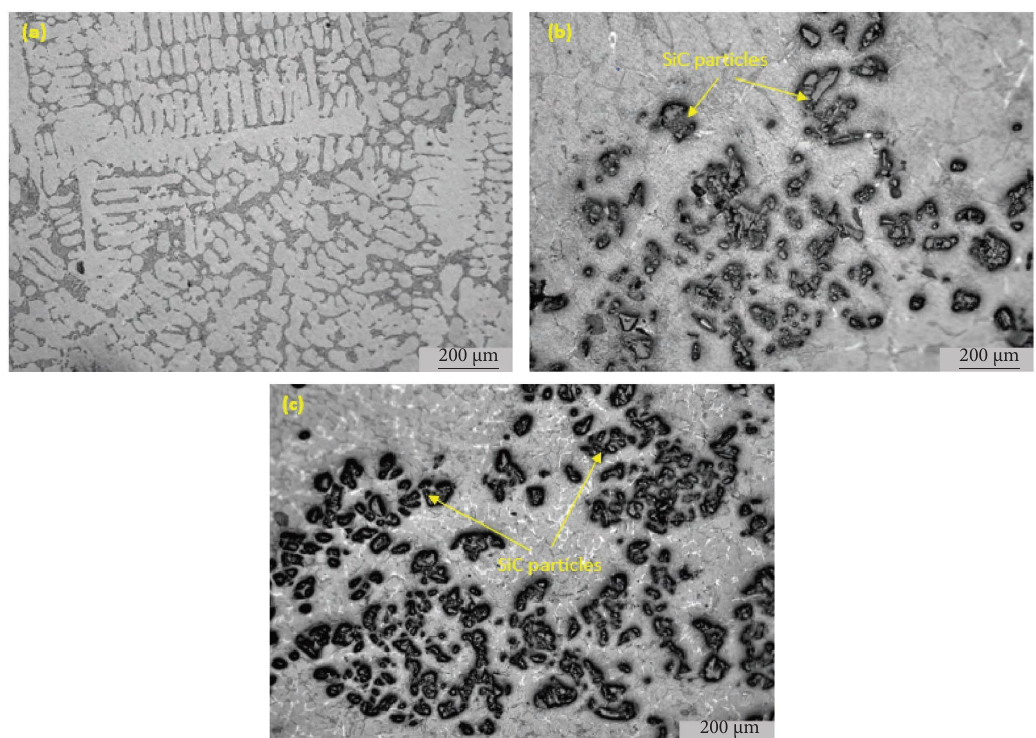
Figure 4: Optical micrographs of (a) Al6061 alloy, (b) Al6061-10% SiC composite, and (c) Al6061-20% SiC composite.